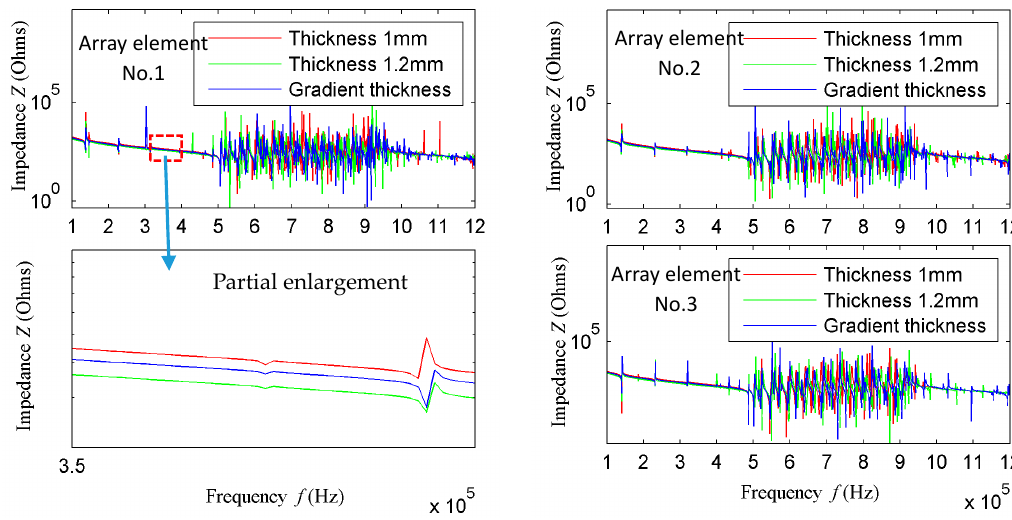
Figure 6. Impedance curves of different thicknesses of array element 1–3 when array-element length is 30 mm.